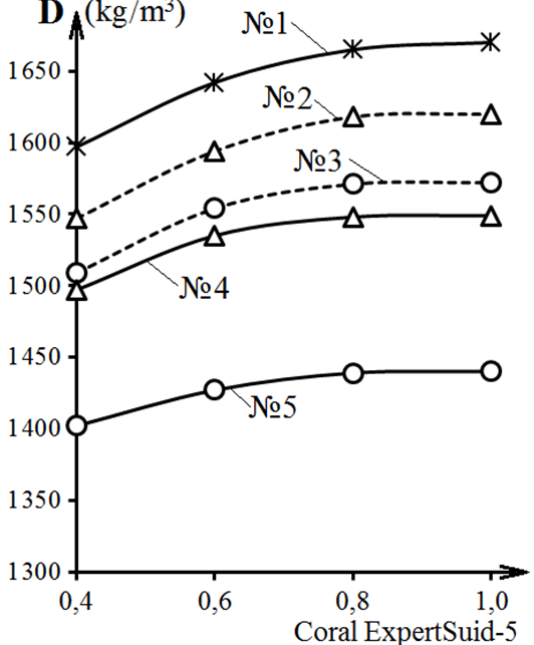
Figure 4. The effect of the amount of plasticizer and the type of sand on the average density of lightweight expanded clay concrete.